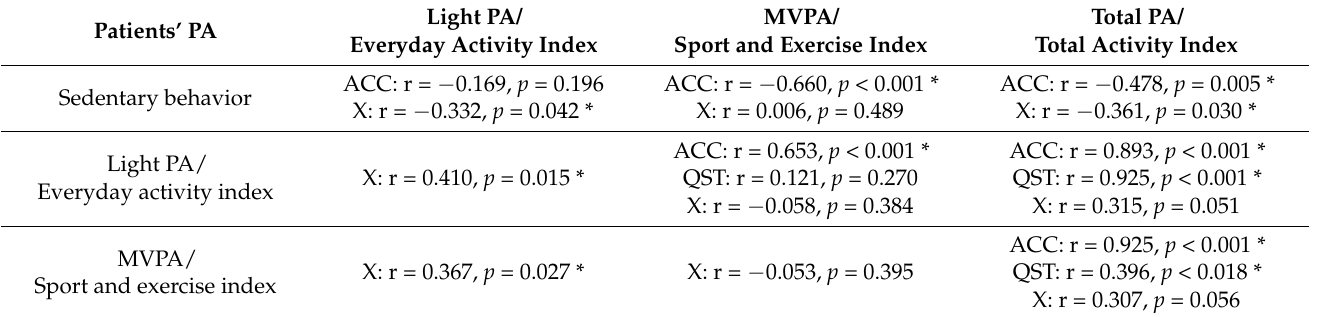
Table 3. Group-specific interrelatedness of PA determination by accelerometry and self-report. Patients’